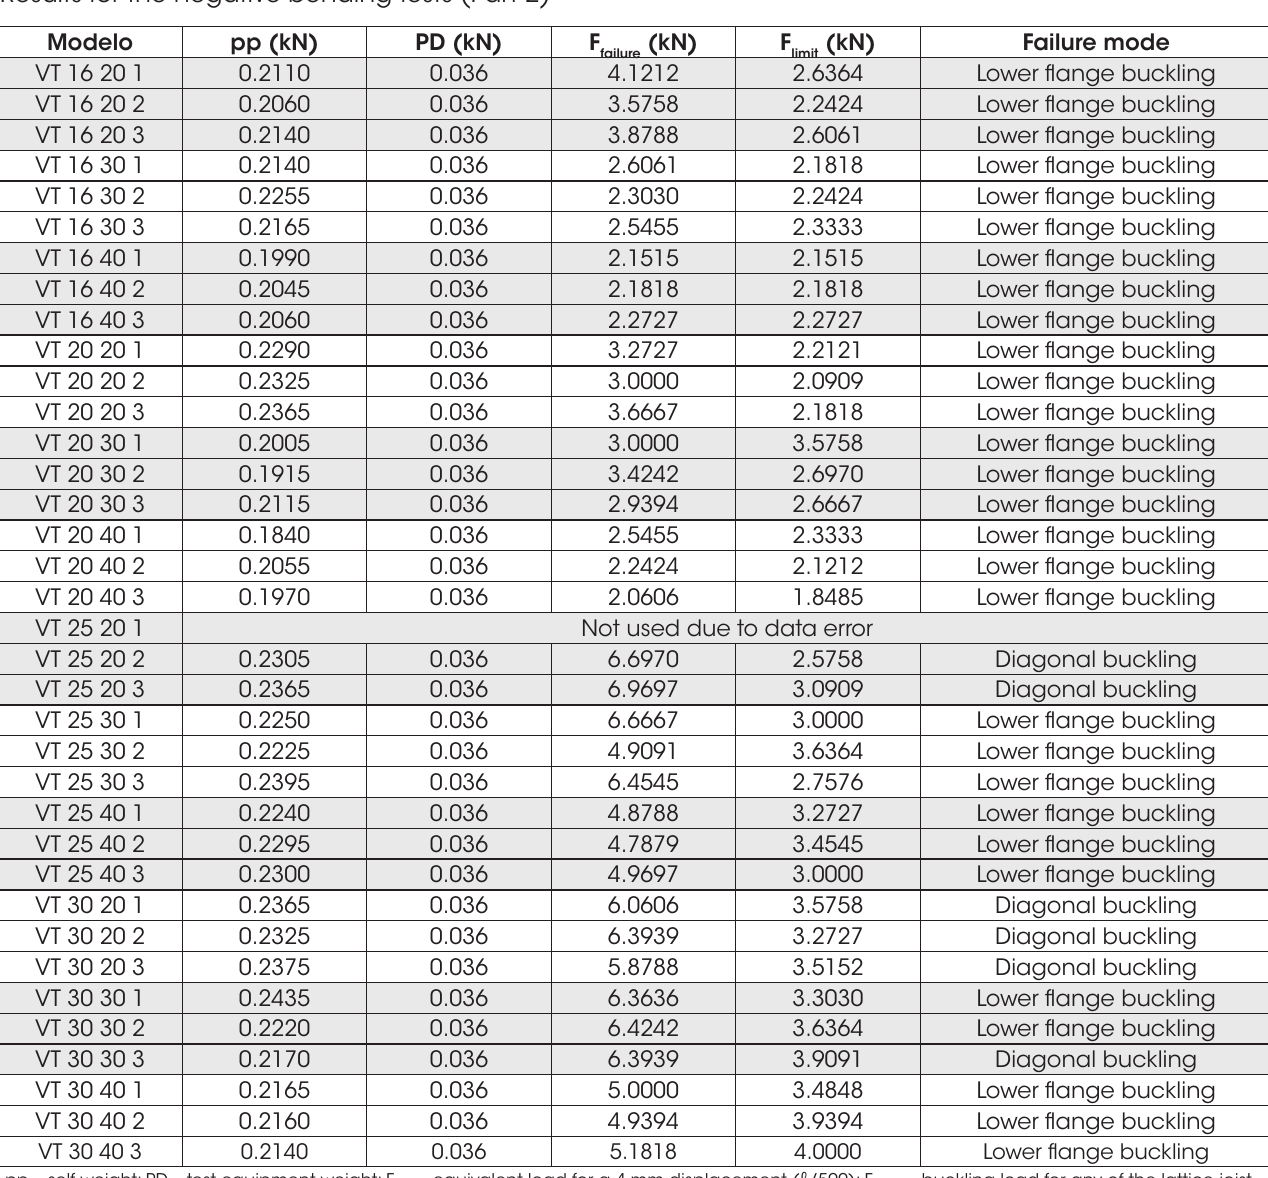
Lower flange buckling